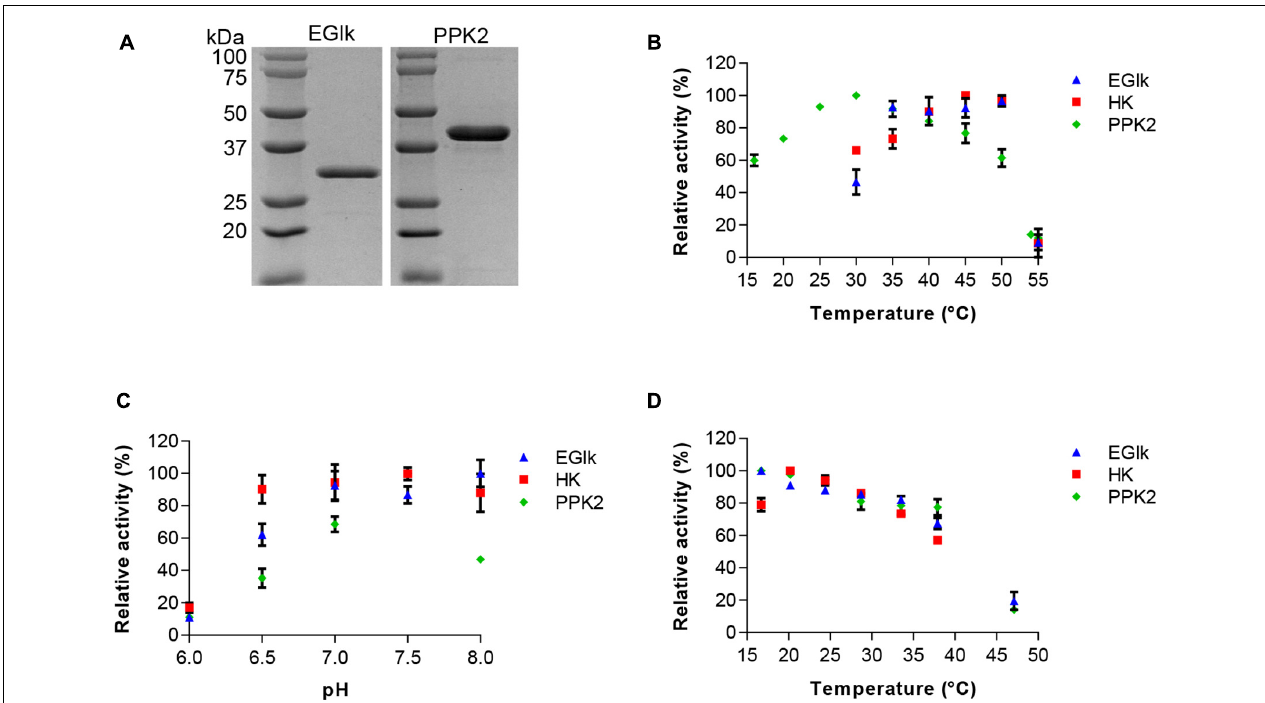
FIGURE 1 | Characterization of HK, EGlk, and PPK2 enzymes. (A) Coomassie stained SDS-PAGE depicting recombinantly produced and purified EGlk and PPK2 enzymes. Characterization of HK, EGlk and PPK2 enzymes in terms of (B) temperature and (C) pH-optimum and (D) temperature stability. Residual enzyme activity was determined after a 24-h incubation at the indicated temperatures. EGlk and HK activities were determined using a coupled enzyme assay. PPK2 activity was determined using a Luciferase ATP determination assay. All data represent mean and standard error of the relative activities measured in triplicates. Where not visible, the error bar is smaller than the symbol